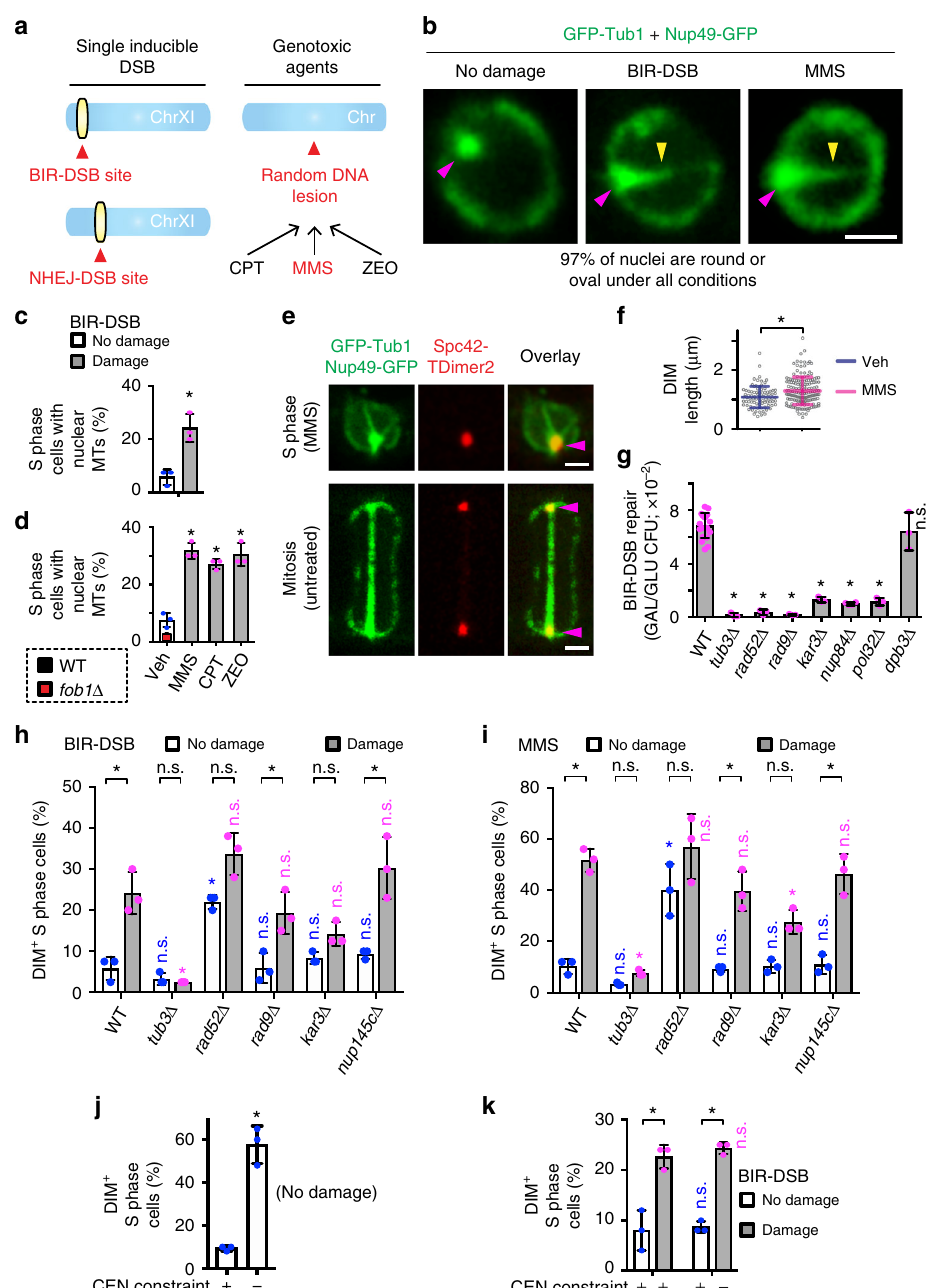
Fig. 1 Identi fi cation of DIMs and its modulators. a Systems used to induce DNA damage. b Confocal imaging of nuclei in cells under non-damaging and DNA- damaging conditions. Arrowheads, MTOC (magenta) and microtubule fi laments (yellow). c , d Intranuclear microtubule fi lament quantitation via confocal microscopy. Veh vehicle. e Confocal imaging showing DIM emanating from an S-phase cell MTOC and differing from the mitotic spindle. f DIM length measurements. g Quanti fi cation of BIR-DSB repair. WT wild type. h , i Effect of different gene knockouts on DIM levels. Wild-type cells in ( c , h ) are the same. j Effect of relieving centromeric constraint on DIMs. k Effect of combining BIR-DSB induction with the relief of centromeric constraint. b , e Scale bar, 1 µ m. c , d , f , g Mean ±s.d.; N = 3. * P ≤ 0.03, two-tailed unpaired t test. h – k Mean ± s.d.; N = 3. * P ≤ 0.015, two-way ANOVA Sidak ’ s multiple comparison test. n.s., not statistically signi fi cant. Statistical symbols in blue indicate a comparison to undamaged WT control, magenta to damaged WT control, and black compares undamaged to damaged cells for each genotype. Individual data points of undamaged (blue) and damaged (magenta) cells are shown (Fig. 1h, i). This result is important, as Tub3 is not essential for Cells de fi cient in homologous recombination-based processes mitotic or meiotic spindle formation 36 . In addition, loss of Rad52 are hypersensitive to MMS treatment 31 . Similarly, ef fi cient BIR/ homologous recombination-based repair of the BIR-DSB requires induced DIMs even before BIR-DSB activation or MMS Tub3, Rad52, Rad9, Nup84, and Kar3 (Fig. 1g) 4 . Therefore, we treatment (Fig. 1h, i). In fact, upon damage induction, DIM asked if these repair-promoting factors alter DIMs in cells levels were not further induced in rad52 Δ cells (Fig. 1h, i). Similar subjected to BIR-DSB or MMS. In both cases, TUB3 knockout results were obtained in cells lacking the Rad51 homologous ( tub3 Δ ) suppressed DIMs following DNA damage induction recombination protein (Supplementary Fig. 1f). Additionally, the NATURE COMMUNICATIONS| (2018) 9:2567 |DOI: